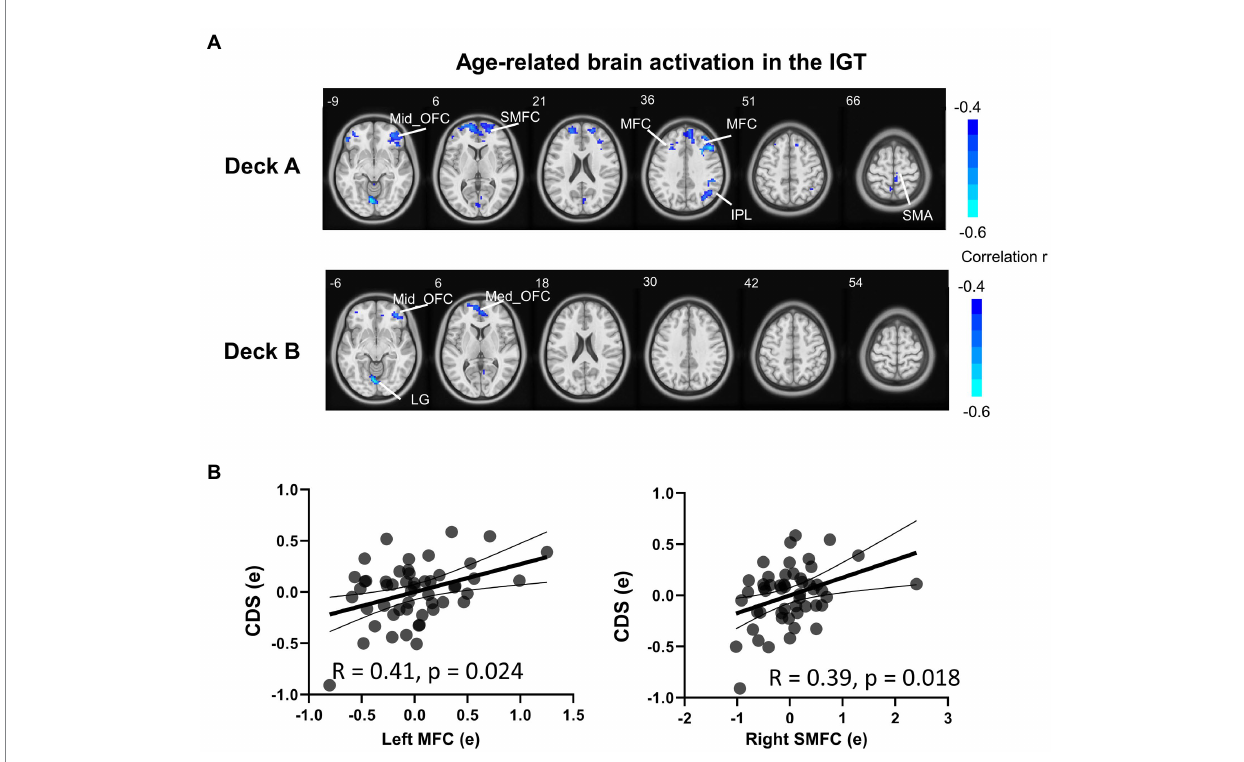
FIGURE 4 Brain activation associated with age during the IGT. (A) The results showed significantly negative correlations between age and brain activation in multiple brain regions in disadvantageous decks, but not in advantageous decks. (B) In the condition of deck A, the brain activations were significantly correlated with CDS in the left MFC and right SMFC (FDR corrected p < 0.05). The correlation analyses were controlled for MoCA, head motion, and GM. MFC, middle frontal cortex; SMFC, superior medial frontal